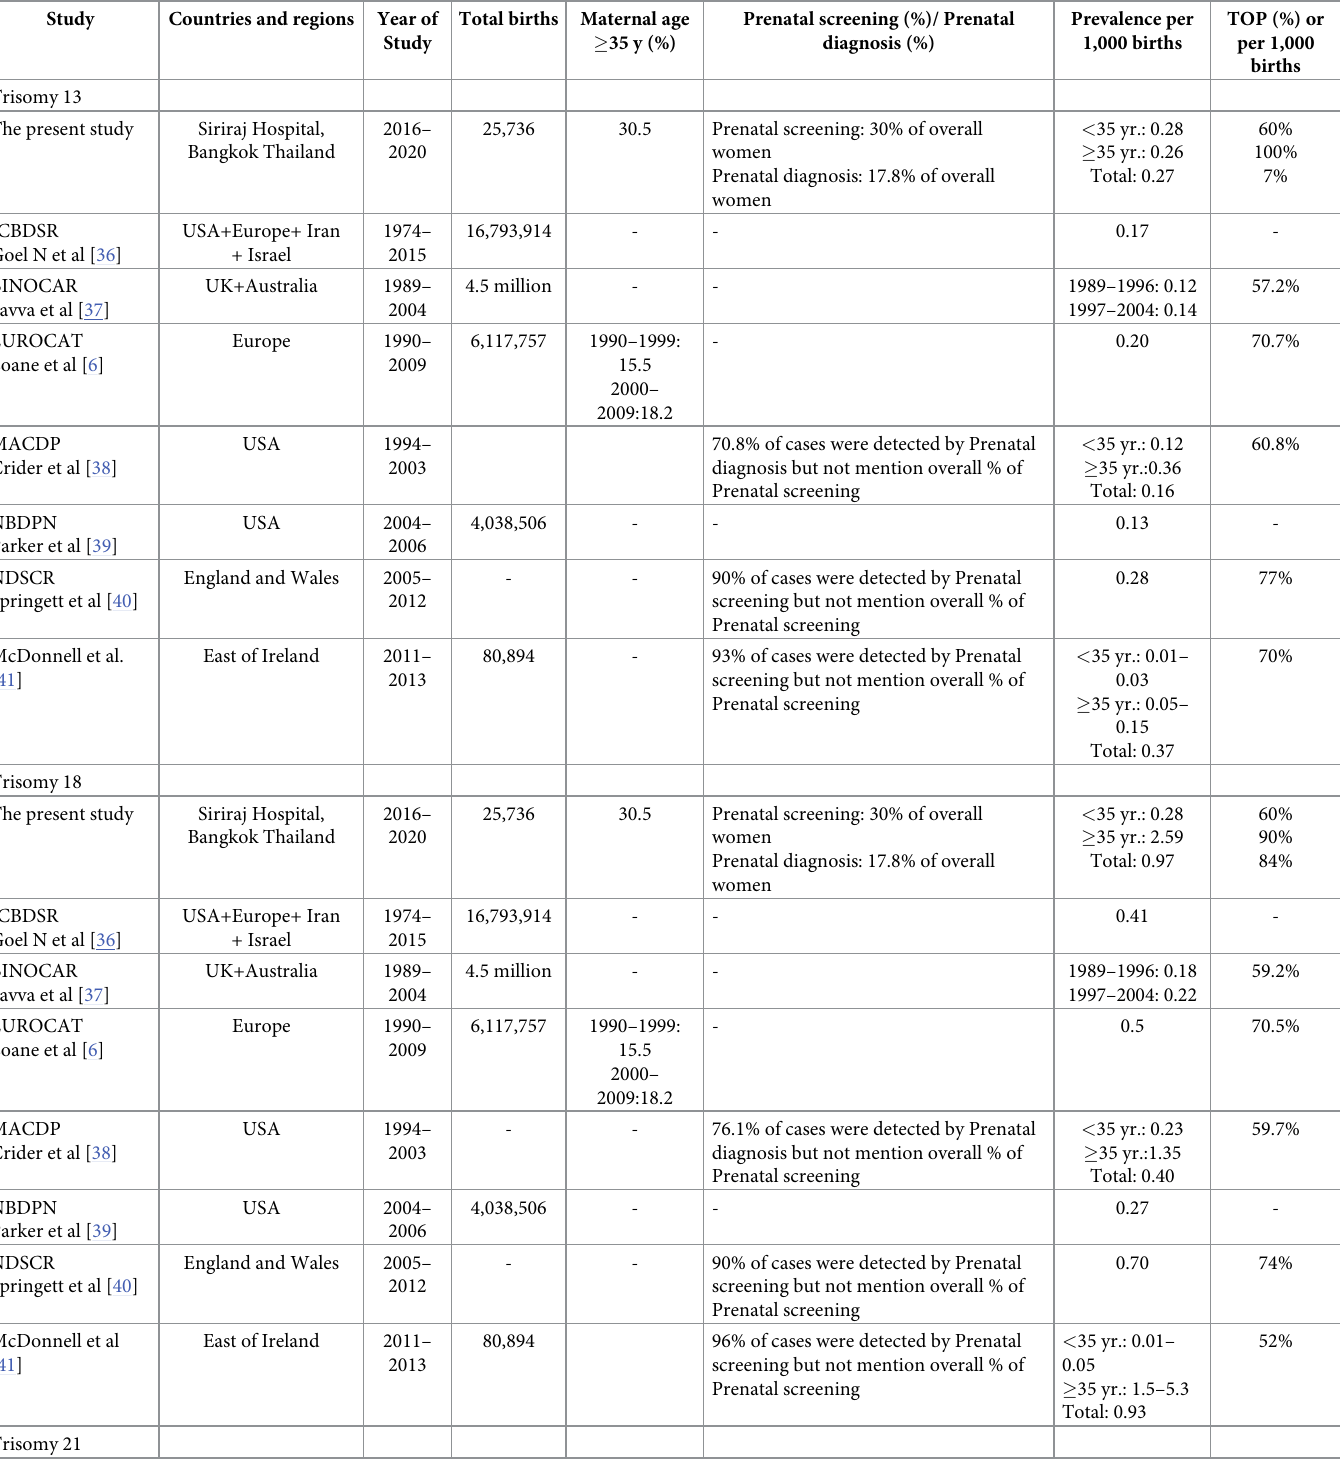
Table 4. Prevalence of trisomy in countries worldwide. Study